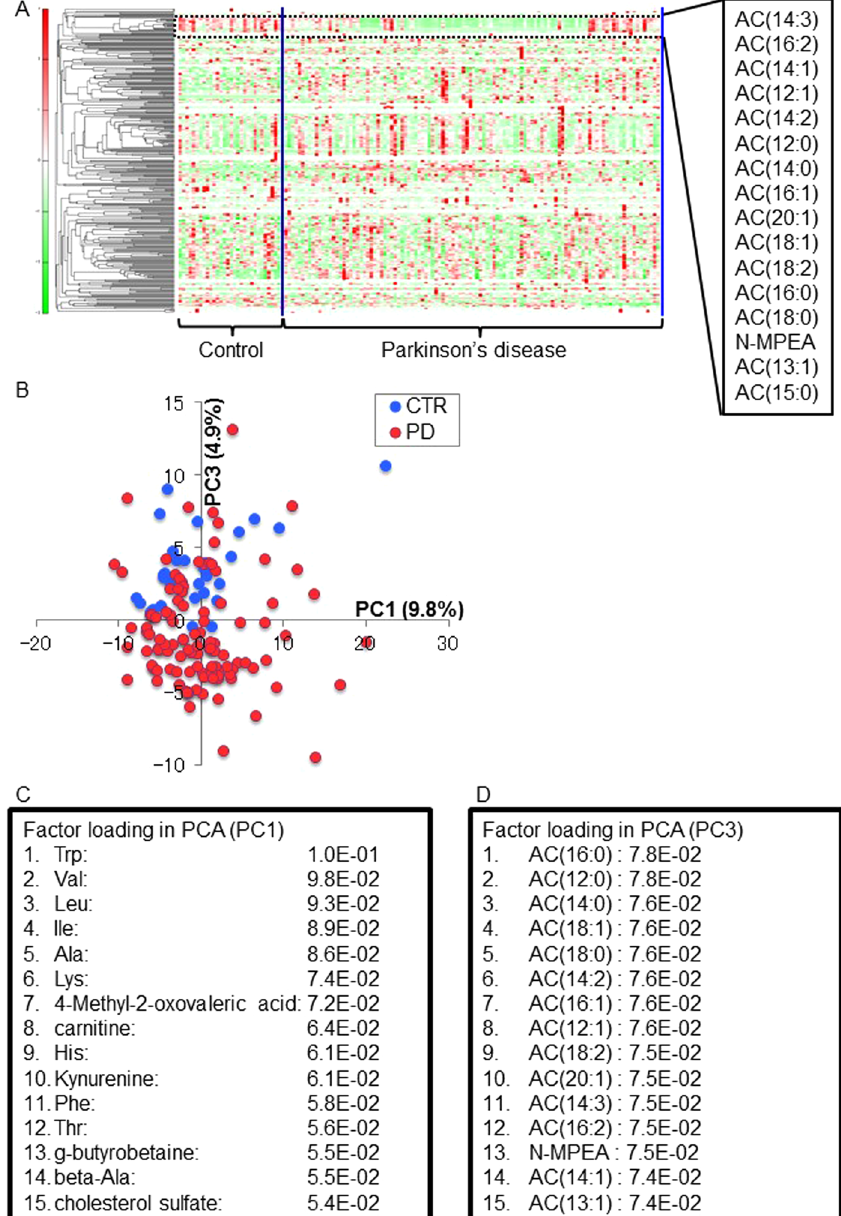
Figure 1. Heat map analysis and cluster analysis of observed metabolomic profiles of the 1 st cohort. ( A ) Red indicates higher than average metabolite concentrations, while green indicates those below average. The order of the metabolites was arranged on the basis of clustering analysis. The dotted line represents a cluster containing long-chain acylcarnitines. ( B ) Principal component analysis of participants’ plasma metabolites arranged by PC1 and PC3. ( C , D ) Factor loading in PC1 and PC3 listed according to statistical significance. Abbreviations: AC = acylcarnitine; CTR = control; PD = Parkinson’s disease; PC = principal component; N-MPEA = N -